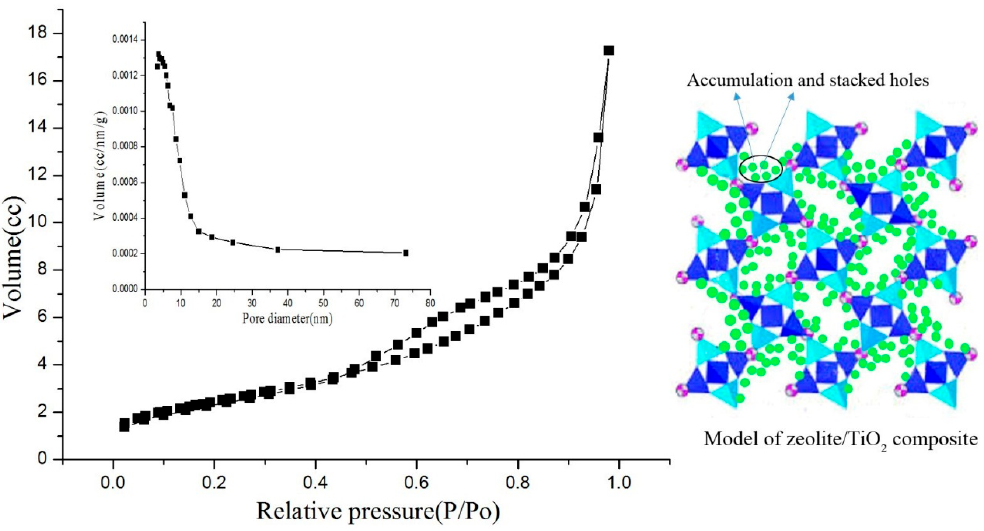
Figure 6. N 2 adsorption–desorption isotherms and pore size distribution of ZTC-2.